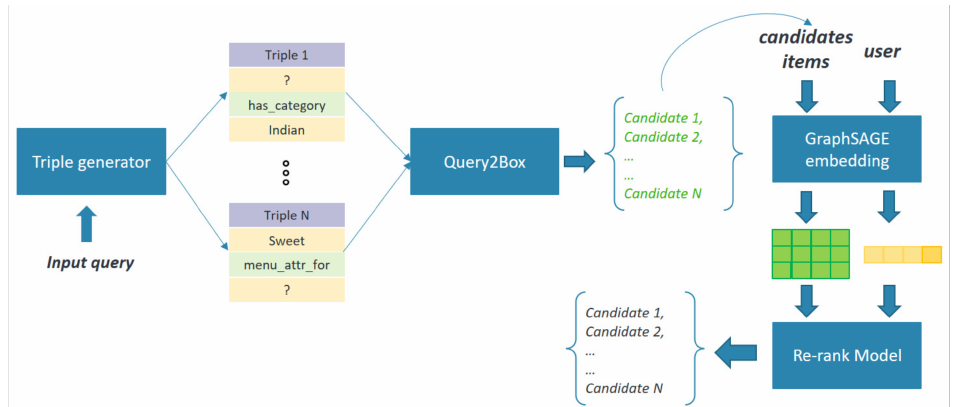
Figure 3. Proposed recommendation